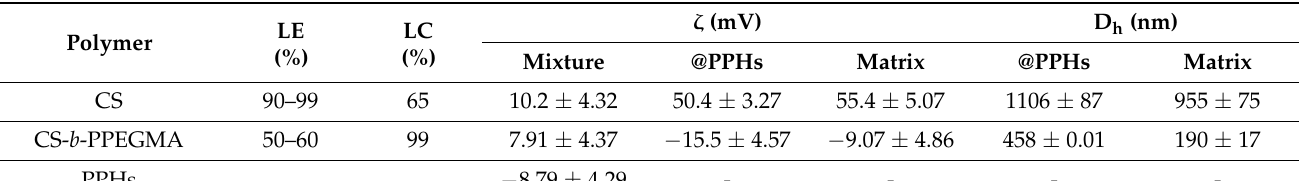
Table 3. Loading Efficiency (LE) and Loading Content (LC) of PPHs in polymer matrixes; zeta potential ( ζ ) and particle sizes of loaded (@PPHs) and unloaded (Matrix) polymer matrixes. Values represent the mean ± standard deviation (n = 3).